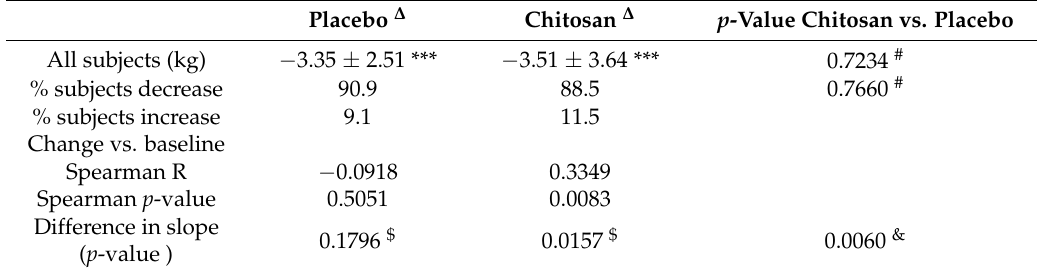
Table 2. Comparison of changes in body weight induced by chitosan and placebo treatments.